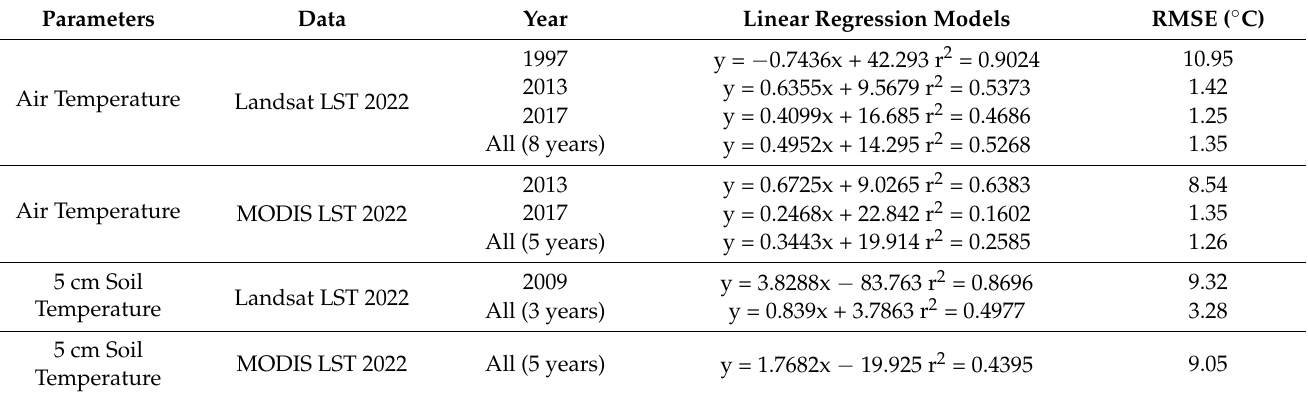
Table 5. Linear regression models (with p ≤ 0.05) and RMSE